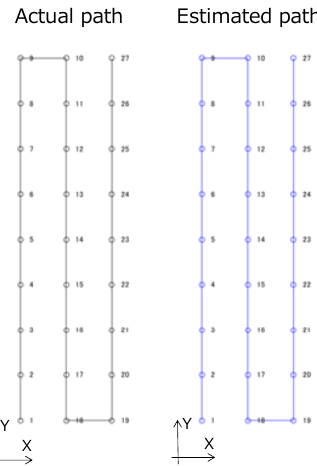
Figure 9. Camera translation estimation result, Elevator hall (Left image: actual camera path, right image: our estimated result)